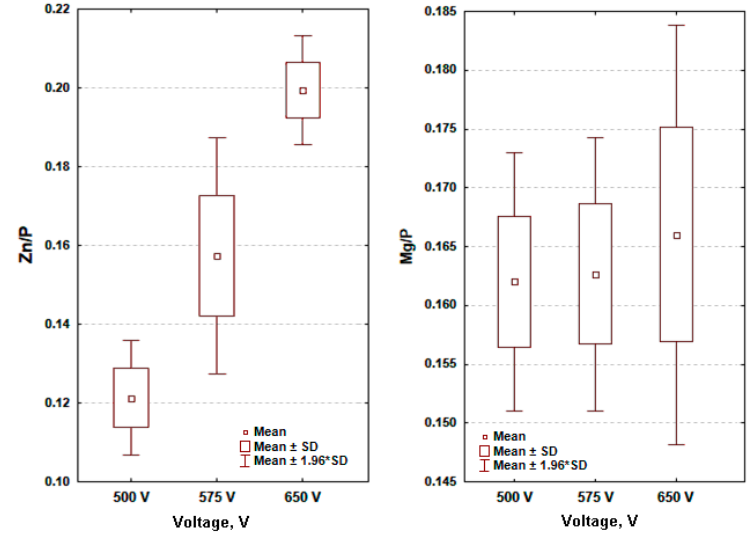
Figure 4. Zn/P and Mg/P ratios of EDS results of coatings formed on CP Titanium Grade 2 after PEO treatment at voltages 500, 575 and 650 V DC in electrolytes containing 500 g·L − 1 of Zn(NO 3 ) 2 ·6H 2 O and 500 g·L − 1 of Mg(NO 3 ) 2 ·6H 2 O in concentrated H 3 PO 4 .